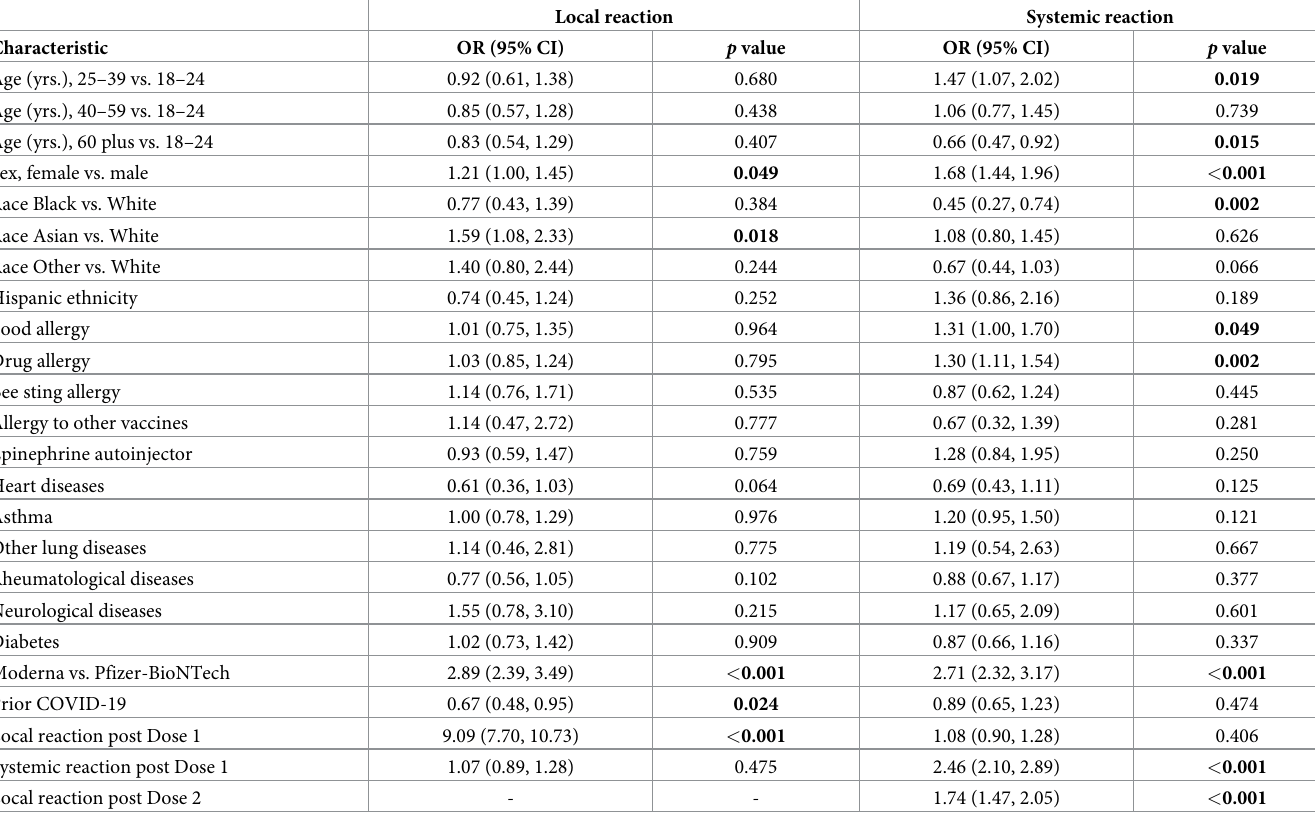
Table 6. Factors associated with local and systemic reactions after second dose of the COVID-19 vaccine.